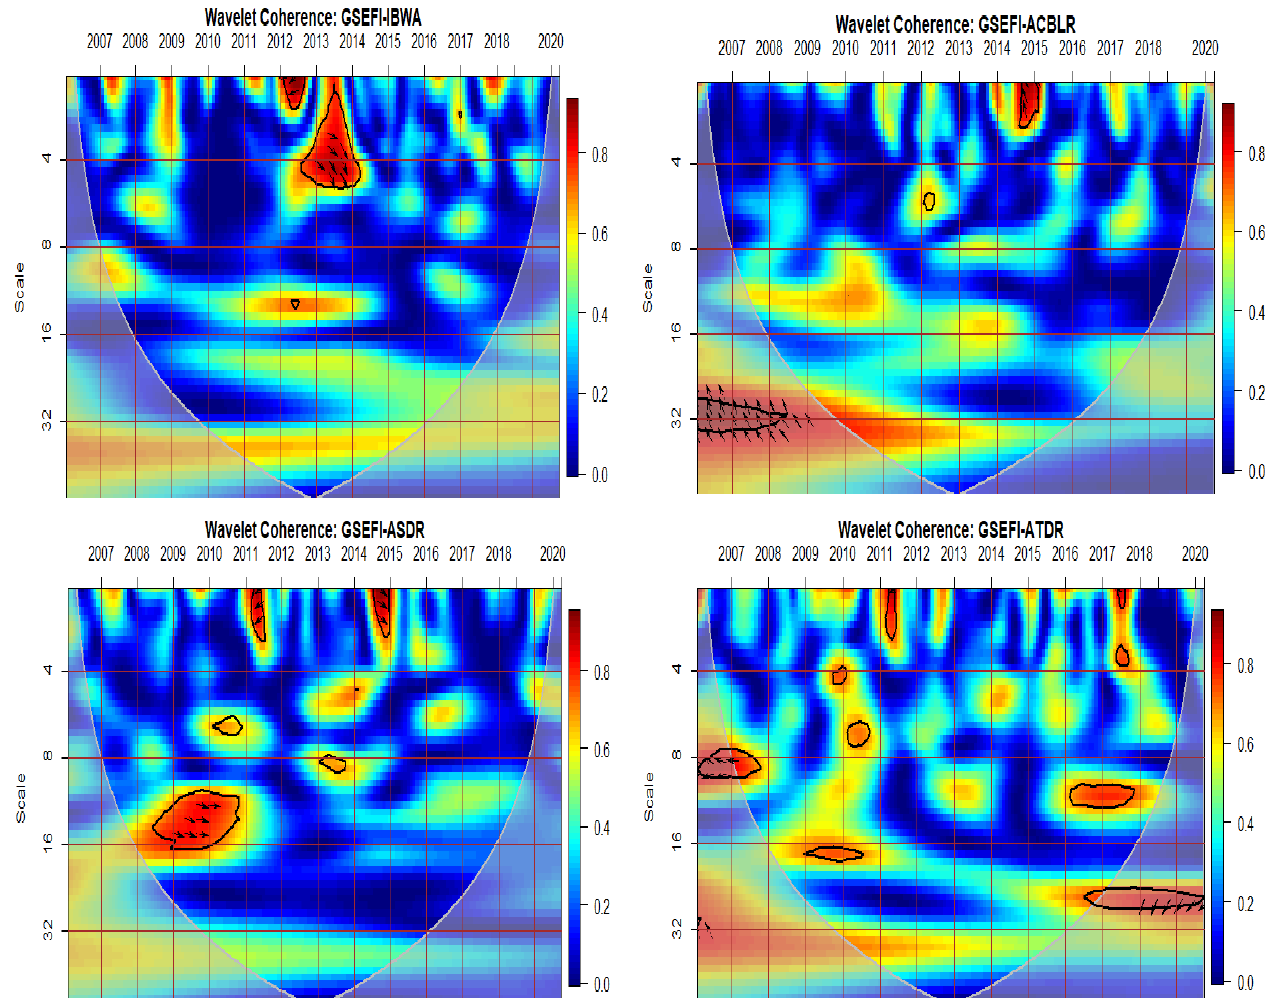
Figure 5. Comovements between GSEFI and interest rates.